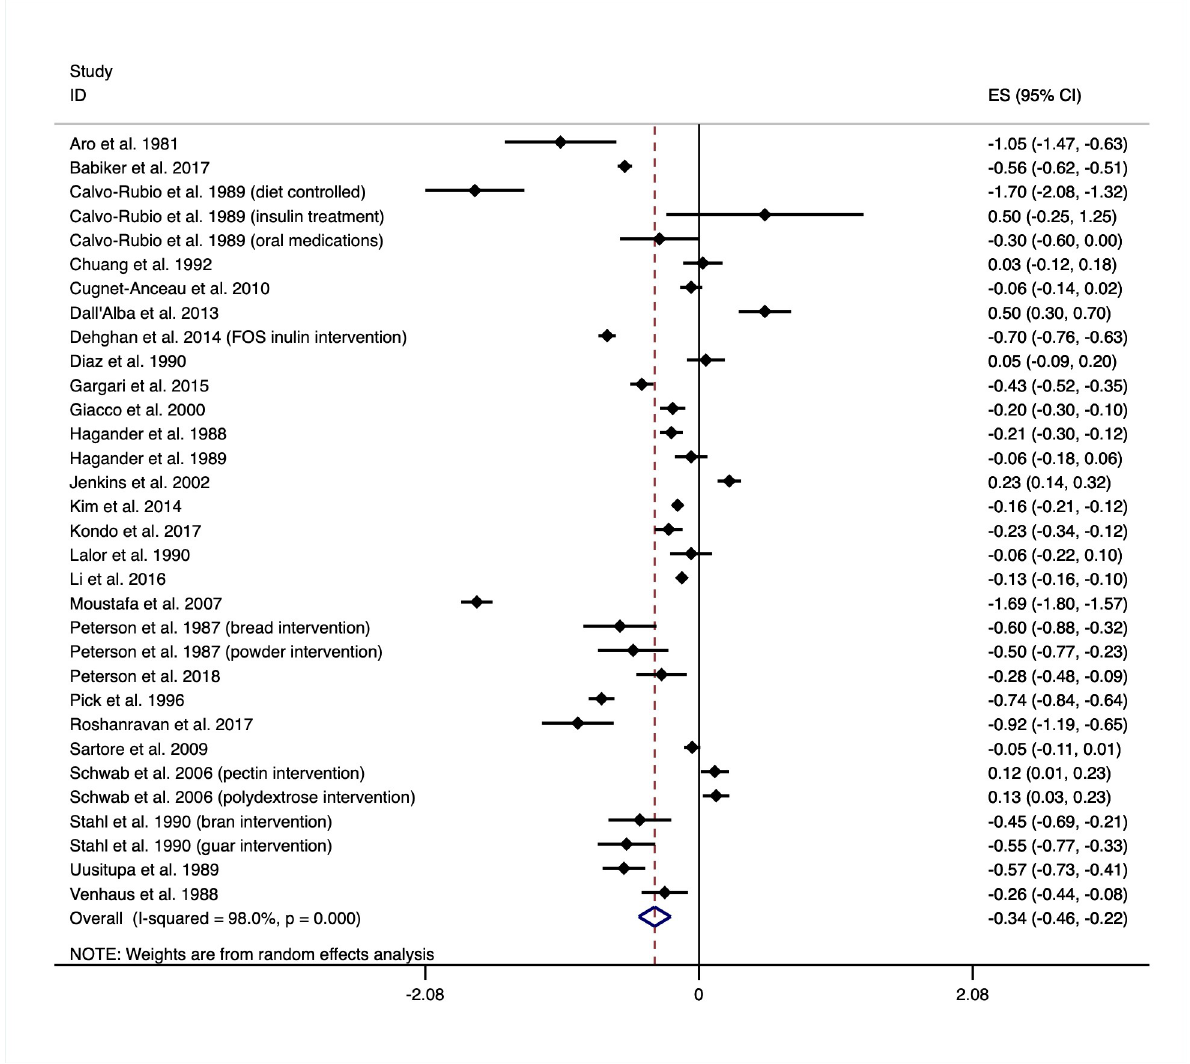
Fig 5. Mean difference in total cholesterol (mmol/L) between intervention and control groups from trials of increasing fibre intakes. Negative values show a decrease in total cholesterol when increasing fibre intakes (the intervention). ES, effect size;